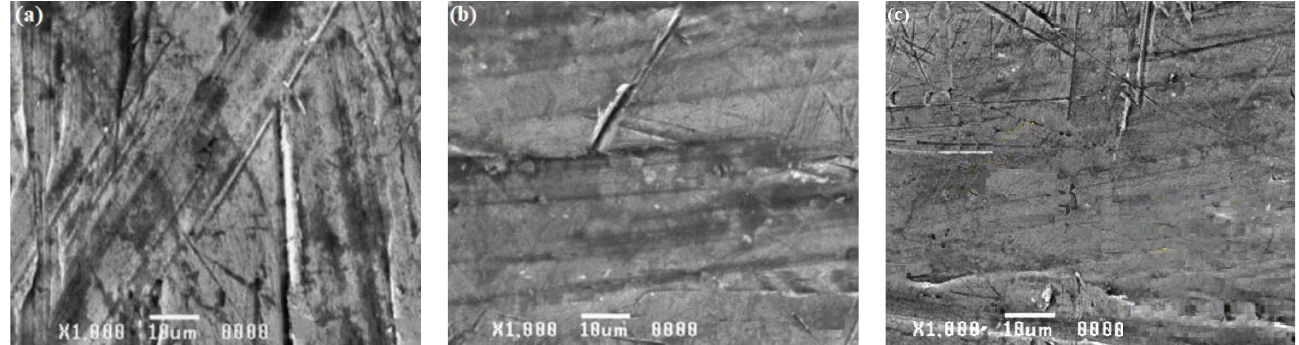
Figure 12. SEM images of ( a ) AA6061, ( b ) AA8011, and ( c ) weld region specimens after submersion testing in seawater.